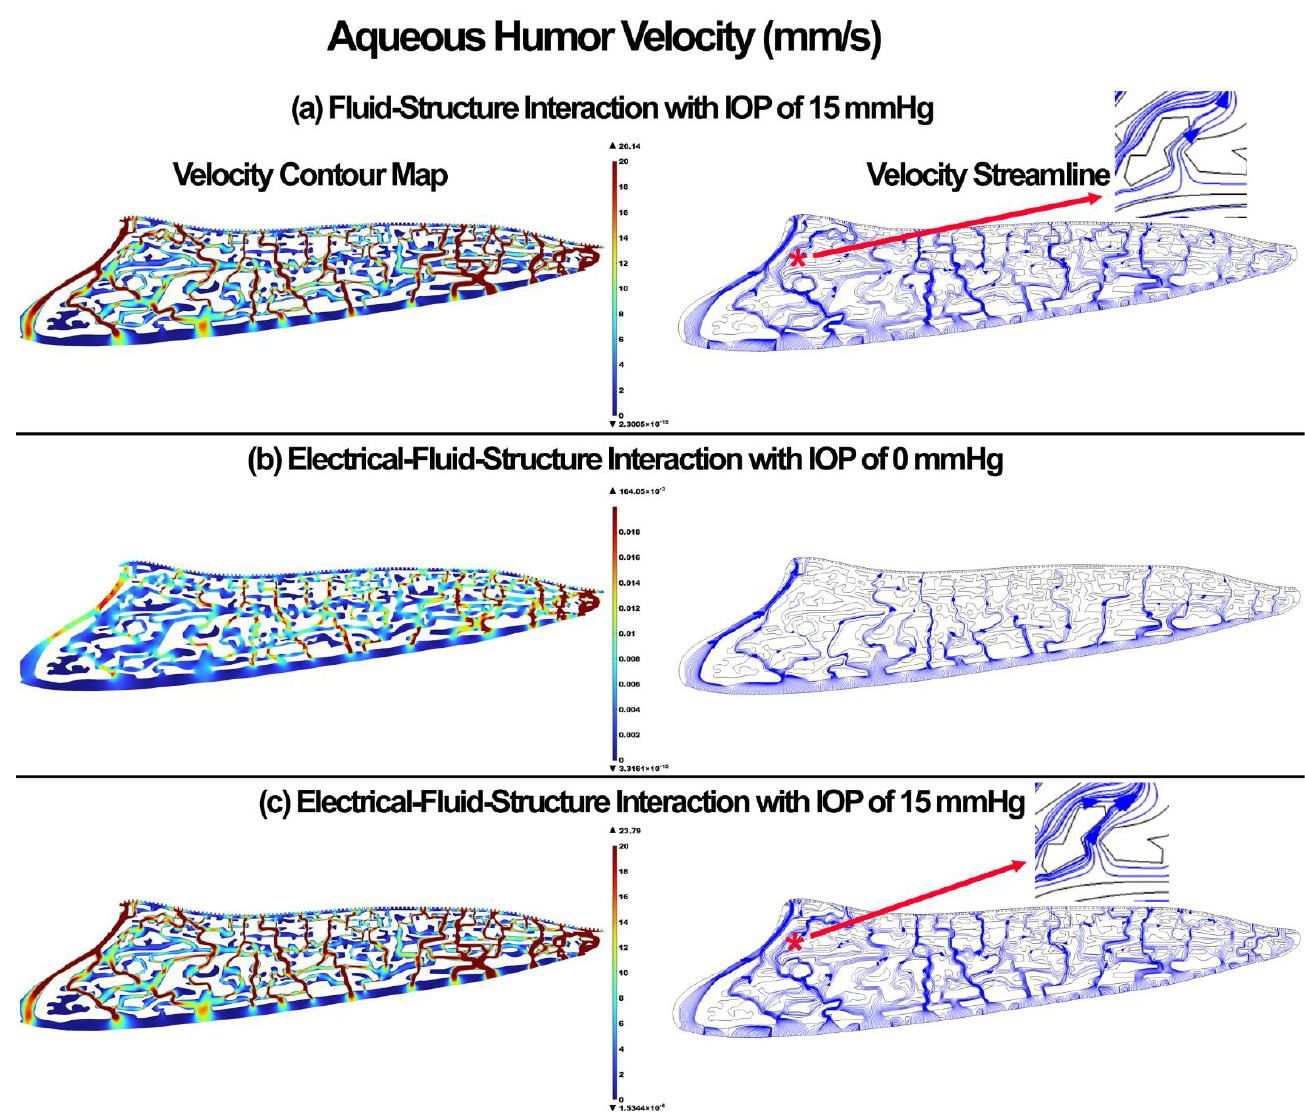
Figure 3. The aqueous humor velocity across the outflow pathway. ( a ) FSI model with IOP of 15 mmHg, ( b ) EFSI with IOP of 0 mmHg, and ( c ) EFSI with IOP of 15 mmHg. The 1st principal stress and strain in the TM/JCT/SC complex for the FSI with IOP of 15 mmHg, EFSI with IOP of 0 mmHg, and EFSI with IOP of 15 mmHg are shown in Figures 4 and 5, respectively. The glycocalyx layer plays a minor role in the resultant stresses and strains in the outflow tissues. The EFSI models showed 0.2 kPa and 0.1% less tensile stress and strain, respectively, in the outflow tissues compared to the FSI model.